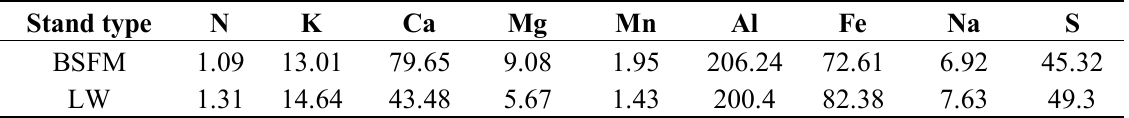
Table 5. Mineral soil nutrient concentrations (N = g·kg −1 , and K, Ca, Mg, Mn, Al, Fe, Na, S = mg·kg −1 ) in scarification furrows and skid trails of harvested and scarified lichen woodlands (LW) and black spruce feather-mosse (BSFM) stands.